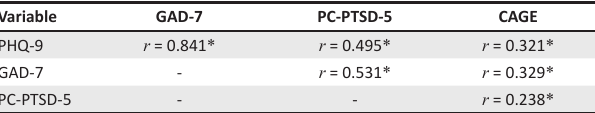
TABLE 7: Inter-scale correlations for PHQ-9, GAD-7, PC-PTSD-5, and